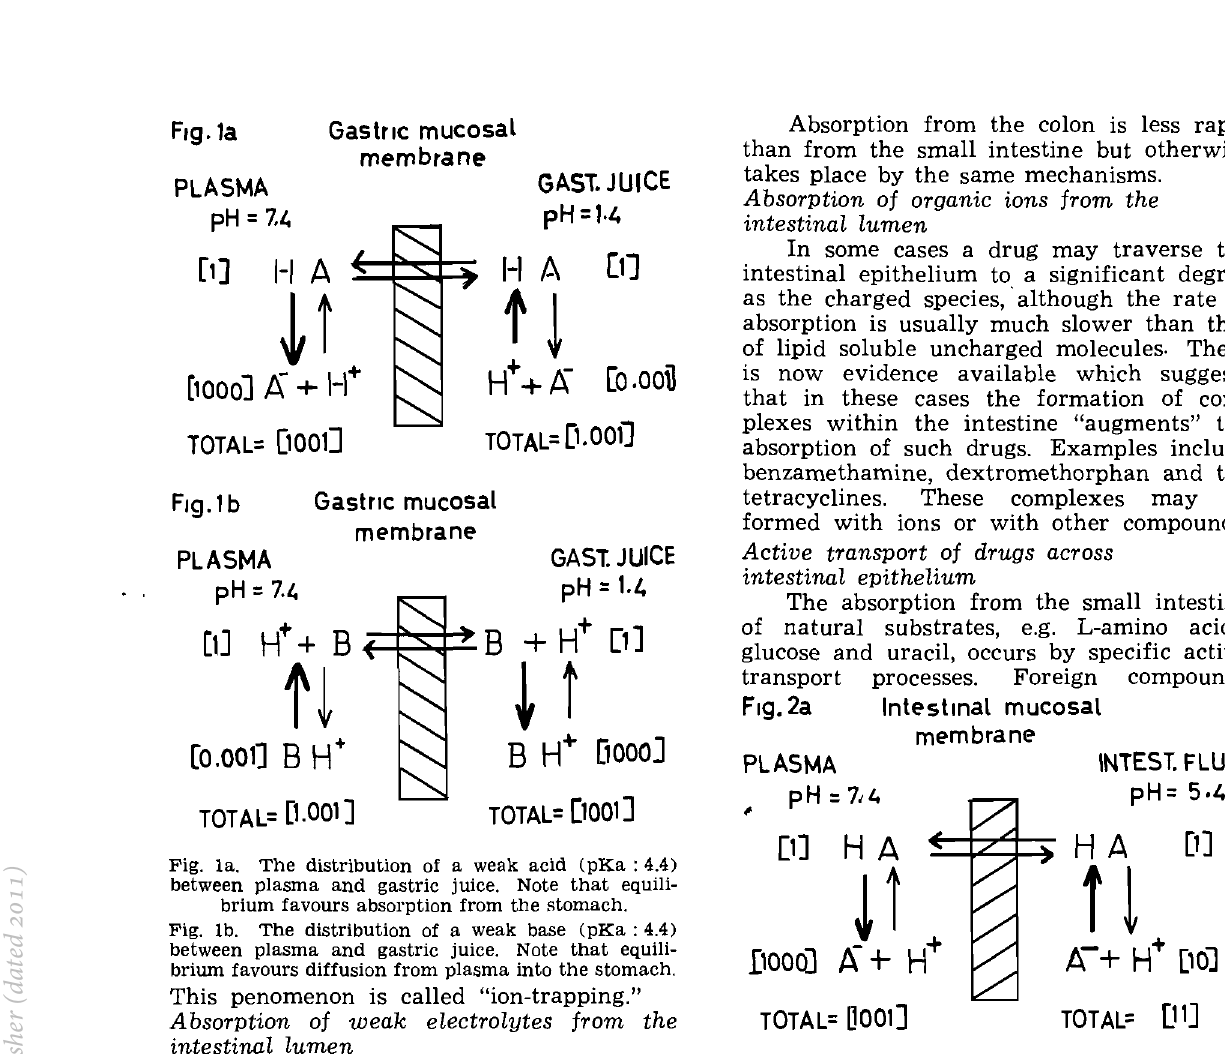
Fig. lao The distribution of a weak acid (pKa: 4.4) between plasma and gastric juice. Note that equili- brium favours absorption from the stomach. Fig. lb. The distribution of a weak base (pKa: 4.4) between plasma and gastric juice. Note that equili brium favours diffusion from plasma into the stomach.